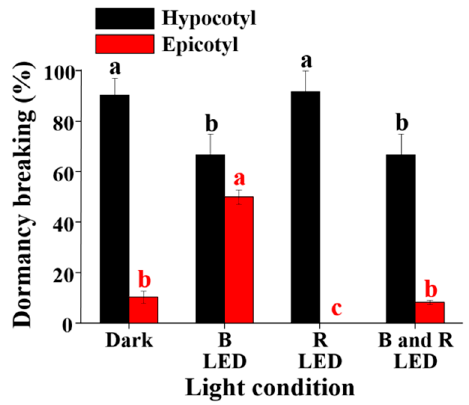
Figure 4. The percentage of hypocotyl and epicotyl dormancy breaking as a ff ected by the concentration Figure 4 . The percentage of hypocotyl and epicotyl dormancy breaking as affected by the of BA and GA 3 . Di ff erent letters indicate separation among treatments by Duncan’s multiple range test concentration of BA and GA 3 . Different letters indicate separation among treatments by Duncan’s at a 5% multiple range test at a 5% level.